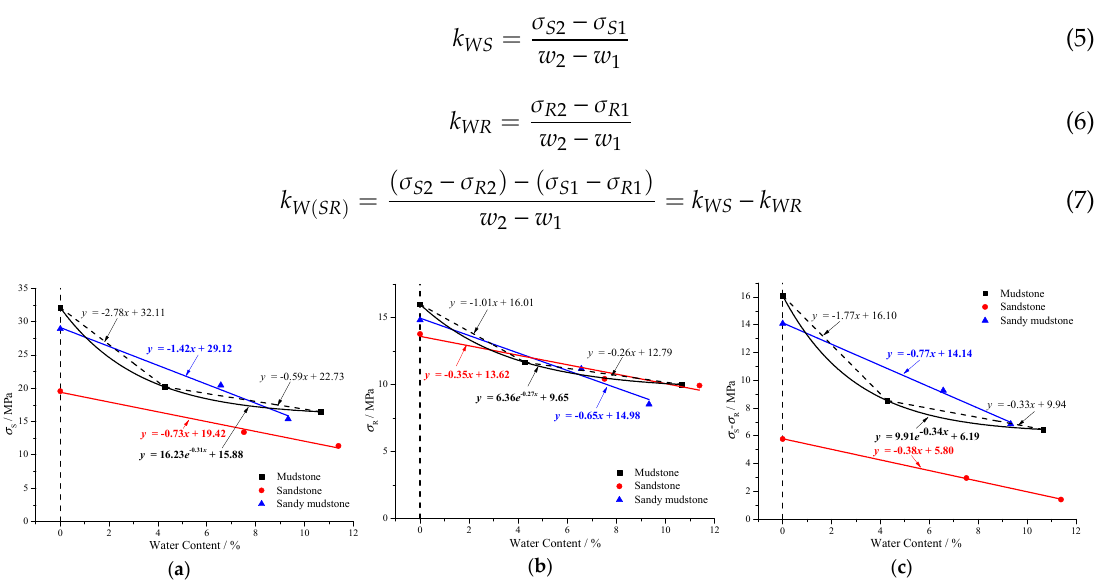
Figure 9. E ff ects of moisture contents on the mechanics behaviors of rock samples. ( a ) Peak stress, Figure 9. Effects of moisture contents on the mechanics behaviors of rock samples . ( a ) Peak ( b ) residual stress, ( c ) di ff erence between peak stress and residual stress, ( b ) residual stress, ( c ) difference between peak stress and residual stress.